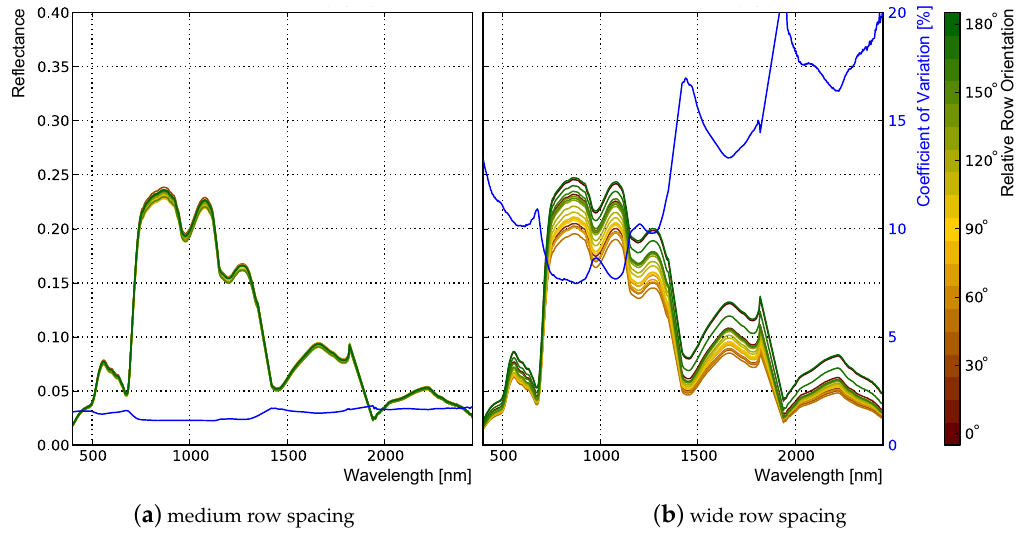
Figure 6. Top-of-canopy reflectance for winter barley canopies during ear emergence with ( a ) medium (13–17 cm) and ( b ) wide (22–26 cm) row spacing. The blue line corresponds to the coefficient of variation of the plotted